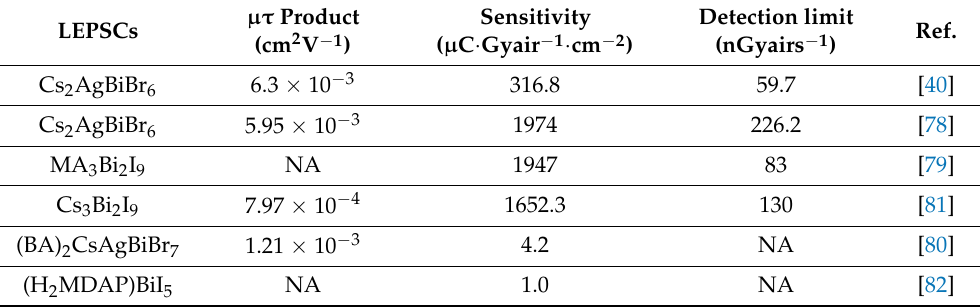
Table 4. X-ray detection parameters of LFPSCs based